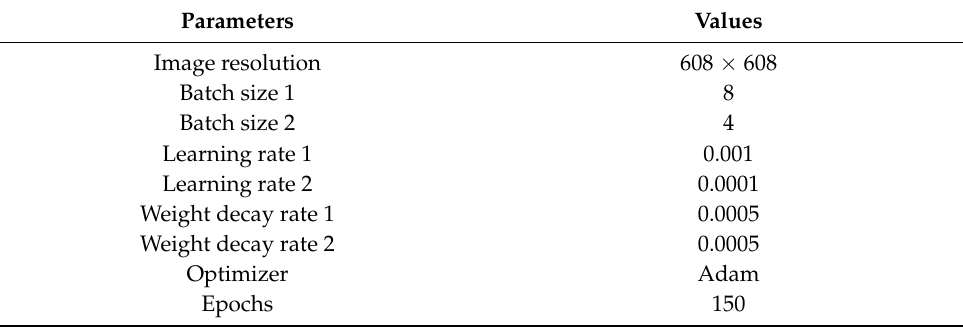
Table 4. The setting of training model